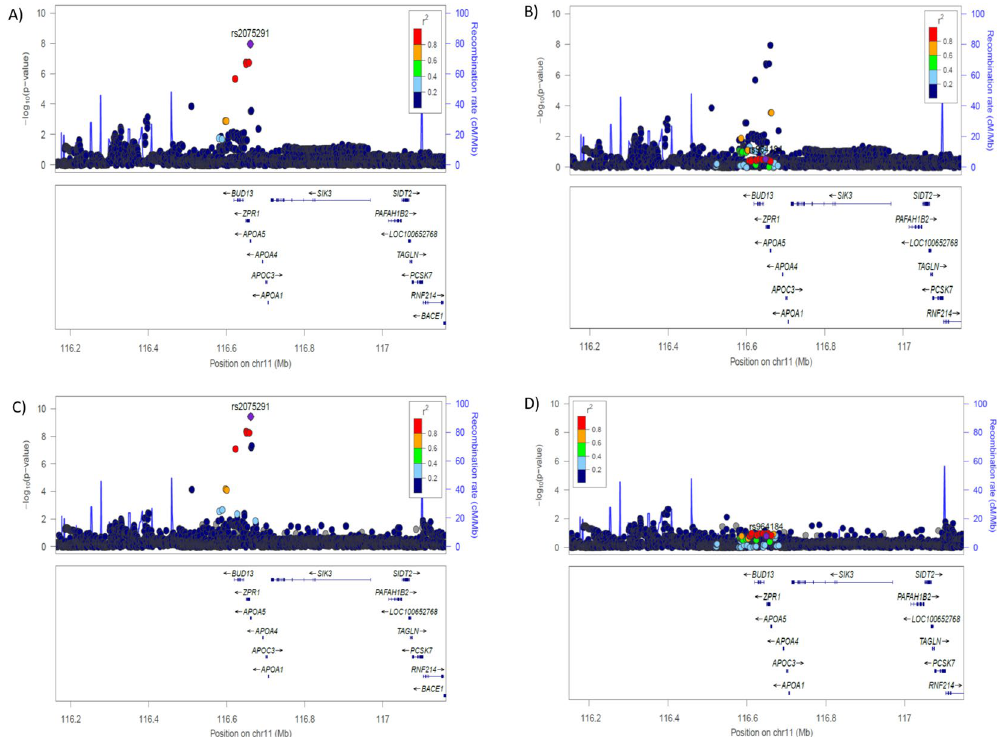
Figure 1. Regional SNP association plots at gene locus containing rs2075291 and rs964184 in the discovery Chinese and Malay Meta-analysis. Gene annotations from the RefSeq track of the UCSC Gene Browser (LocusZoom http://csg.sph.umich.edu/locuszoom/). ( A ) Association levels with rs2075291 as index SNP. ( B ) Association level for rs964184 as index SNP. ( C ) Regional association levels of SNPs after adjustments for rs964184 genotypes. ( D ) Regional association levels of SNPs after adjustments for rs2075291 genotypes. Index SNP of plots indicated by purple diamonds.